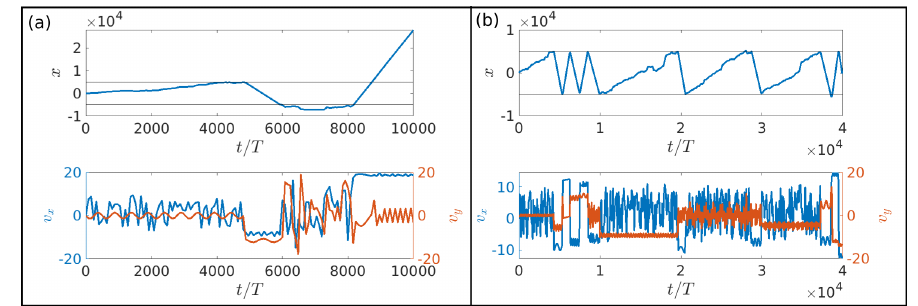
Figure 4. ( a , b ) Trajectories of two typical particles depicting the conversion between diffusive and ballistic dynamics in the setup III. The horizontal black lines at x = x 1 and x = − x 1 in the upper panels denote the left and right edges of the lattices V G 1 and V G 2 respectively. The particle in ( a ) is reflected twice by these two lattices due to the conversion between diffusive and ballistic dynamics. However, the particle in ( b ) undergoes such conversions multiple times over long timescales. The parameters are the same as in Figure